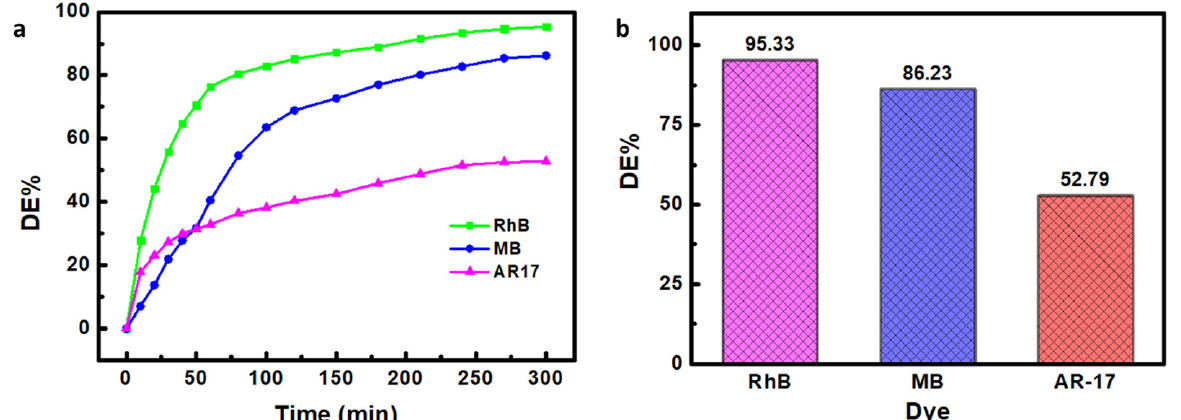
Figure 9. ( a ) Catalytic degradation e ffi ciency of GTU-3 at the dye initial concentration of 10 mg/L (50 mL), [PMS] = 0.5 mM, and GTU-3 = 0.4 g/L, and ( b ) the bar graph of the dyes degradation.